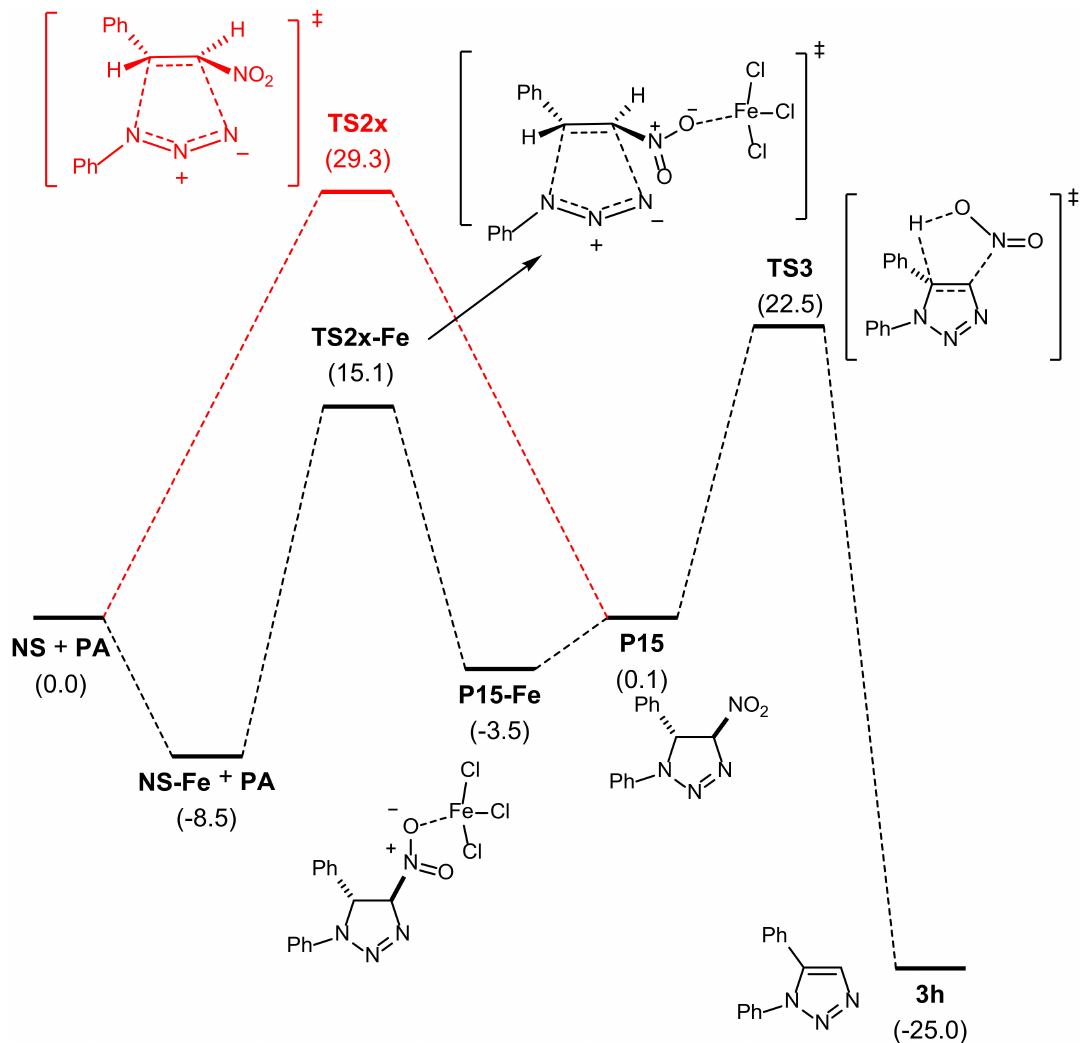
Figure 1. Reaction coordinate for the formation of 3h from ( E )-nitrostyrene and phenyl azide. Both catalyzed (iron(III) chloride) and uncatalyzed (in red) cycloaddition reactions are included for the purpose of comparison. (For detailed data, see Supplementary Materials).